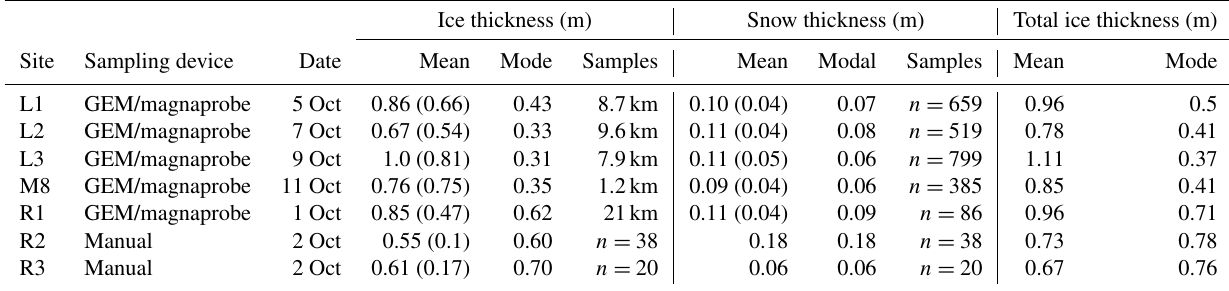
Table 1. Ice and snow thickness observations obtained on various residual ice floes in the immediate vicinity (grey, L1–L3, M8) and extended surroundings (R1–R3) of the Central Observatory. The positions of the sites are shown in Fig. 3a. Sample unit indicates either the distance covered by instruments like GEM/magnaprobe (in kilometres) or the number ( n ) of individual measurements that were performed manually. Numbers in parentheses provide the standard